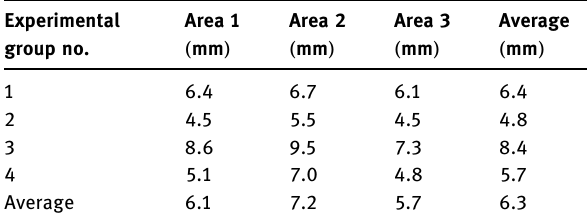
Table 3: Statistical data of yarn spacing Experimental group